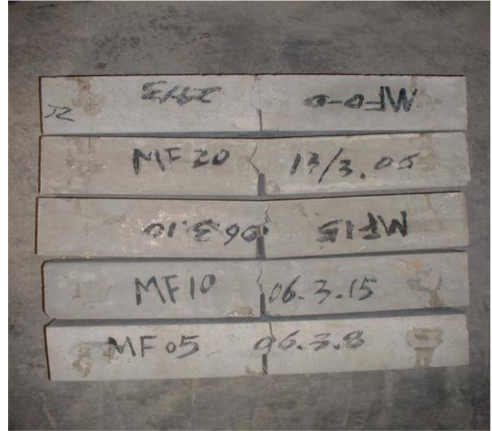
Figure 5. The failure of SFRC.